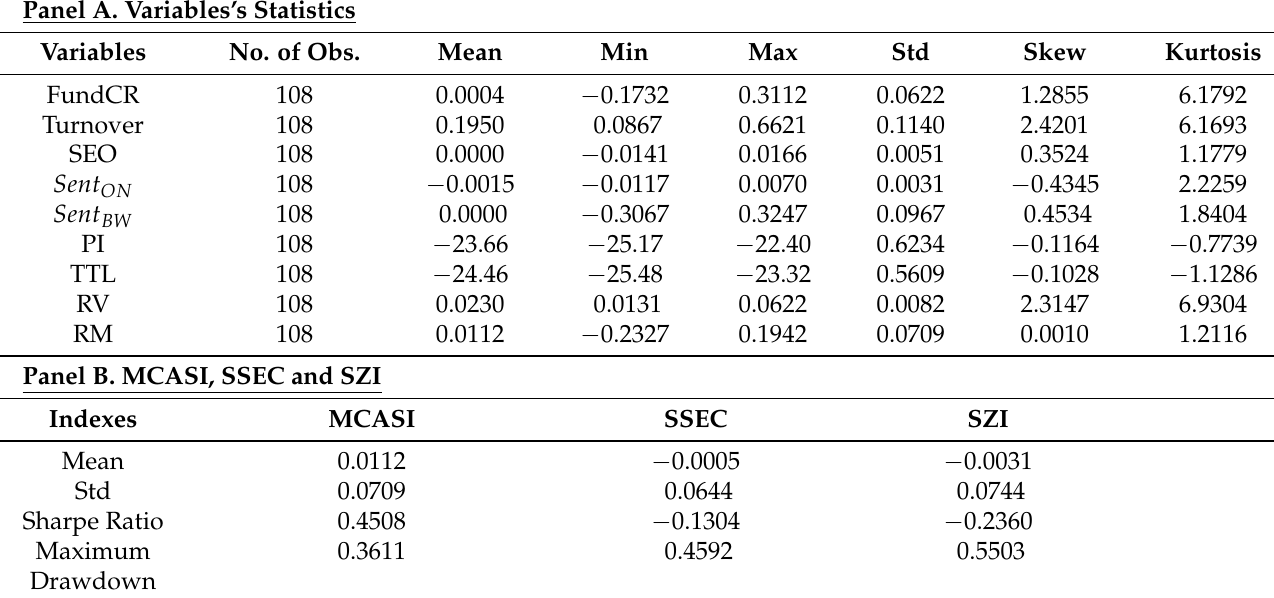
Table 2. Description